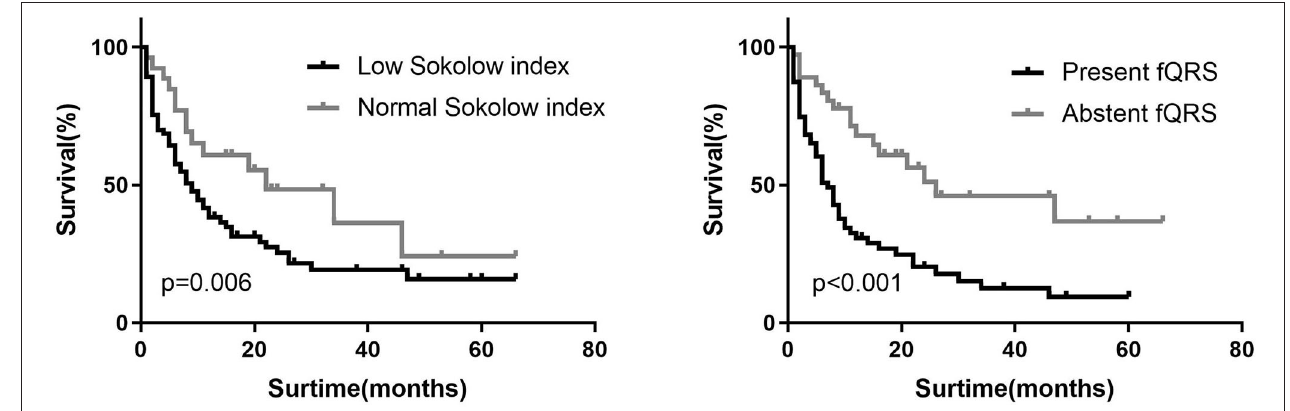
FIGURE 4 | Kaplan–Meier curve for ECG parameters, predicting all-cause mortality in patients with AL amyloidosis.